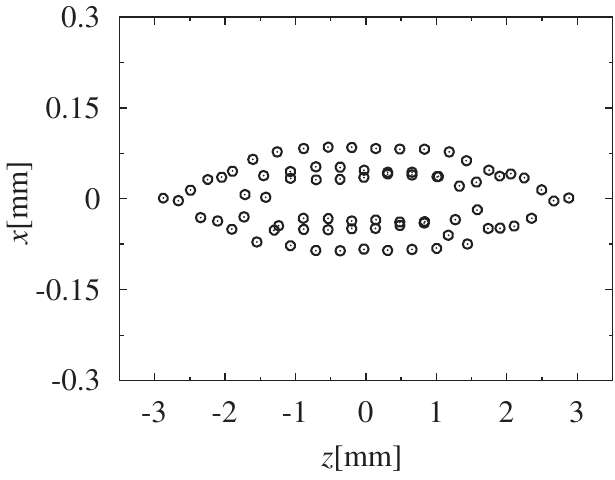
FIG. 9. Spatial configuration (top view) of a bunched beam in (cid:4) (cid:2) (cid:3) 2 : 07 ; 2 : 07 ; 0 : 07 (cid:4) . ; (cid:6) ; (cid:6) S-LSR at the operating point (cid:3) (cid:6) x y z The momentum dispersion of the ring has been suppressed by the electrostatic deflectors. The simple, untapered linear cooling (cid:2) 0 : 20 is applied only in the longitudinal direction force with f z once in every turn. The transverse cooling has been accom- plished by the resonant coupling method based on a special coupling cavity [11] and on a solenoid magnetic field. In order to recover the lattice symmetry, we have switched off the coupling cavity after the cooling is